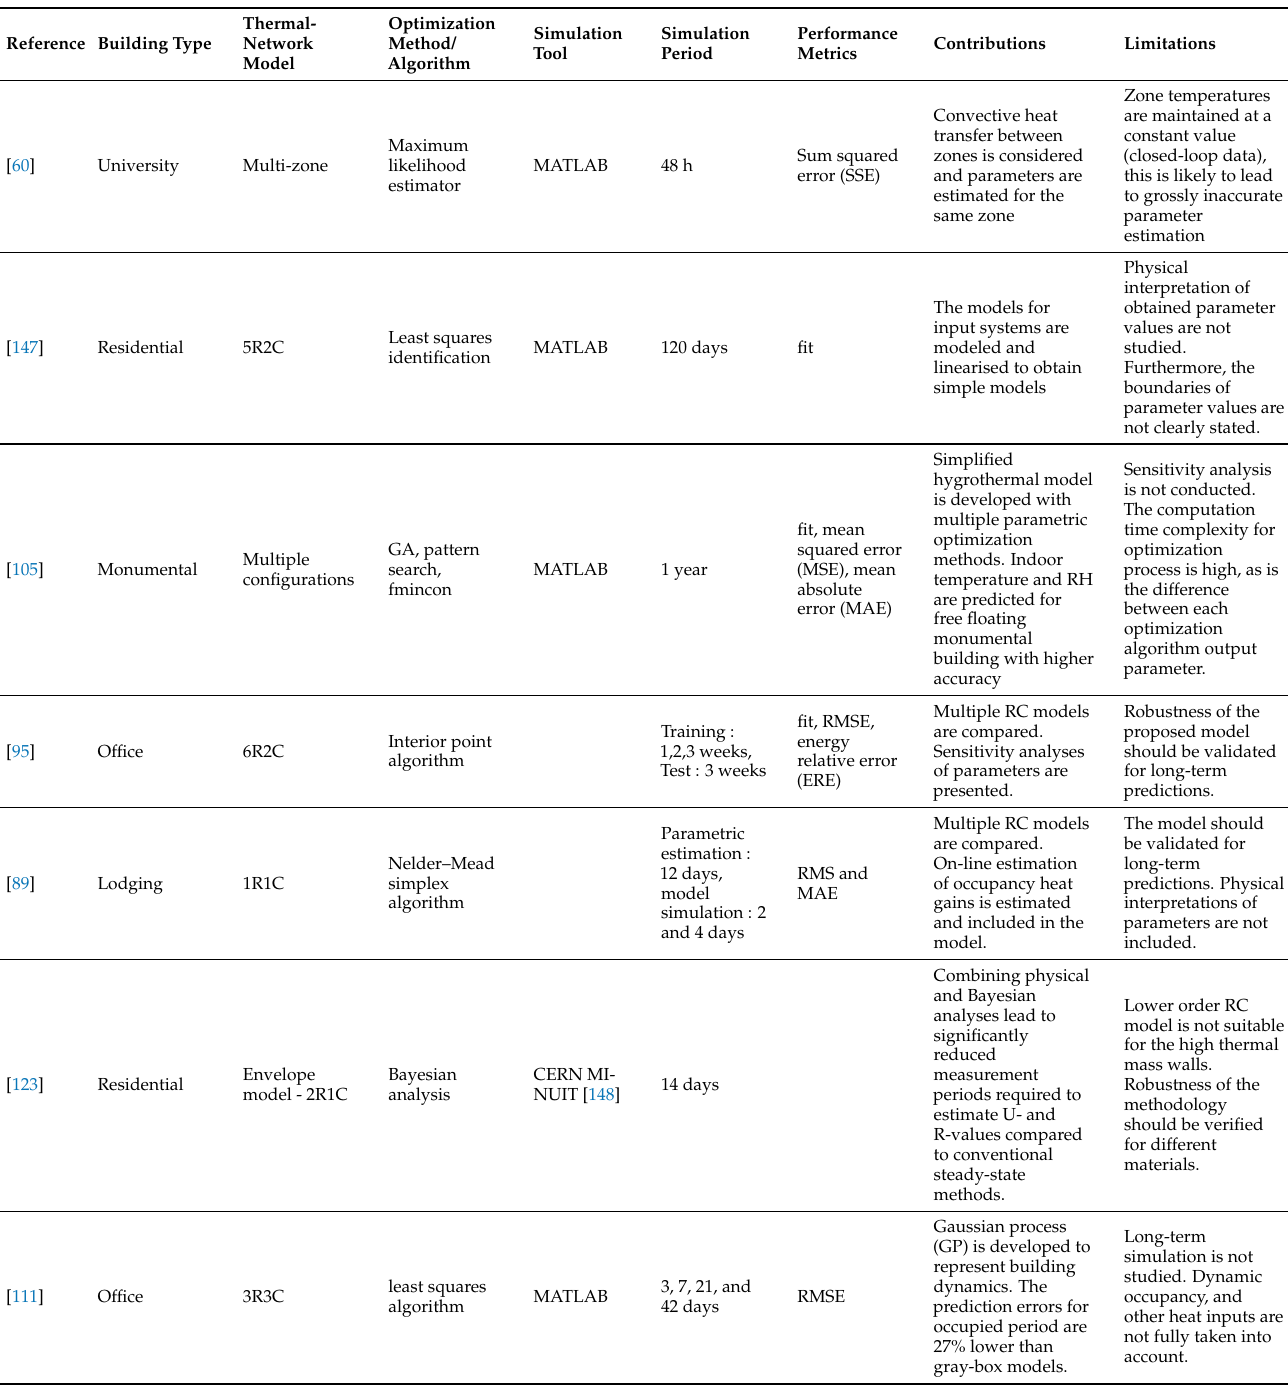
Table 6. Analysis of inverse model developed on optimization